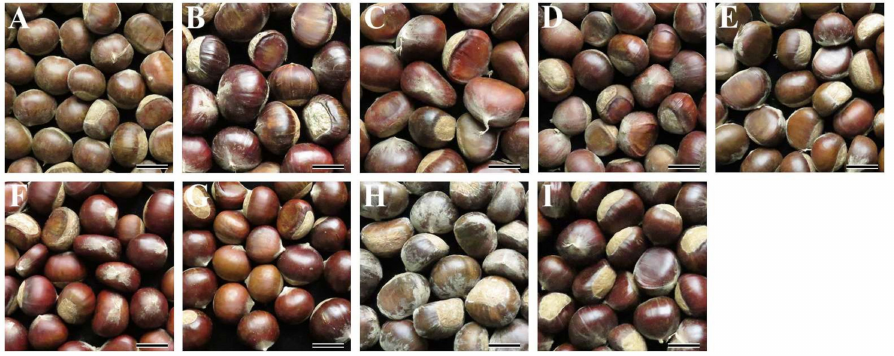
Figure 1. Photographs of nuts from Chinese chestnut variety 3113 ( A ), Benlizi ( B ), Dahongpao ( C ), Erqingzao ( D ), Heishanzhai 7 ( E ), Mi 5 ( F ), Mi 6 ( G ), Yangguang ( H ), and Yanshanhong ( I ). Scale bar = 20 mm. Table 1. Nut and kernel weights and starch content in